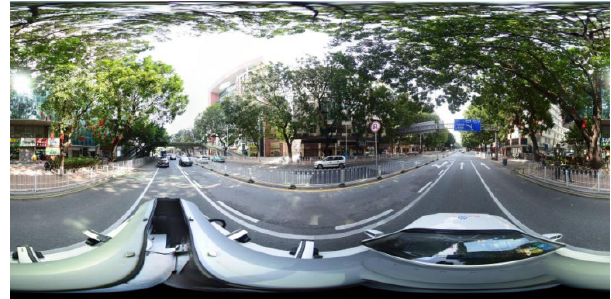
Figure 4. Street Panorama.